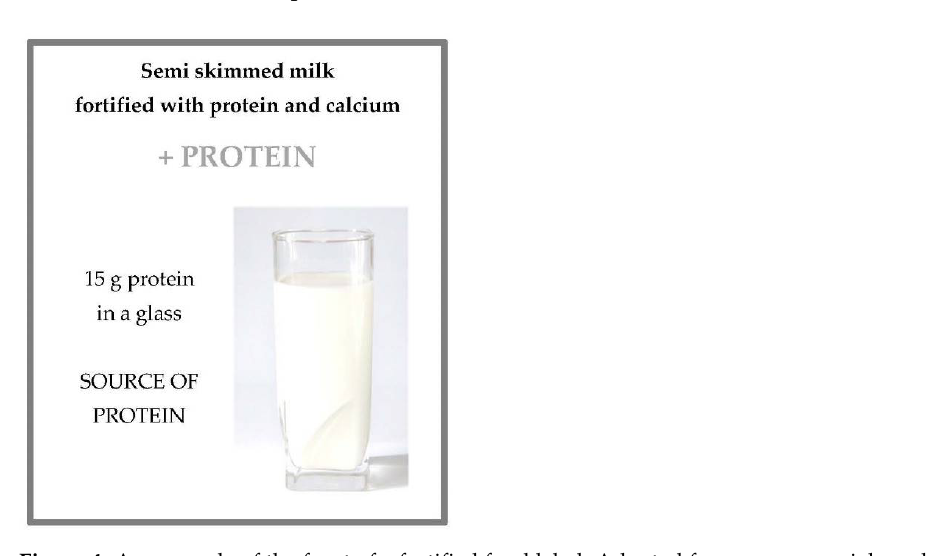
Figure 4. An example of the front of a fortified food label. Adapted from a commercial product .